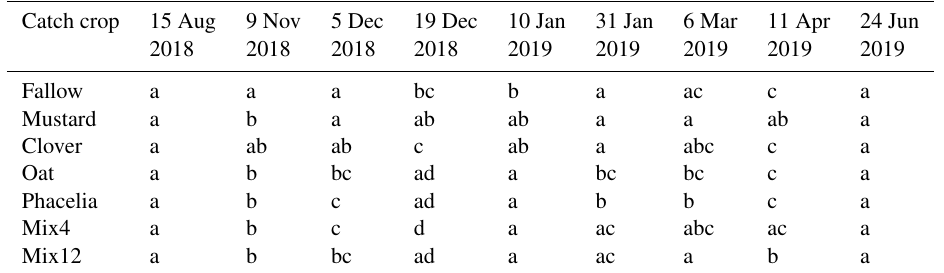
Figure 2. Spatiotemporal resolution of N min concentrations in soil spanning a 313d period under (a) fallow conditions, (b) mustard and (c) clover. The dotted lines indicate CC termination, dashed lines mark the seeding of maize following CCs or fallow and asterisks indicate sampling dates. Table 2. Pairwise comparison of soil mineral N stocks ( N min in kgha − 1 ) from Fig. 5 at the individual sampling dates. R codes and data are provided in the Supplement. Small letters denote the contribution to significantly different